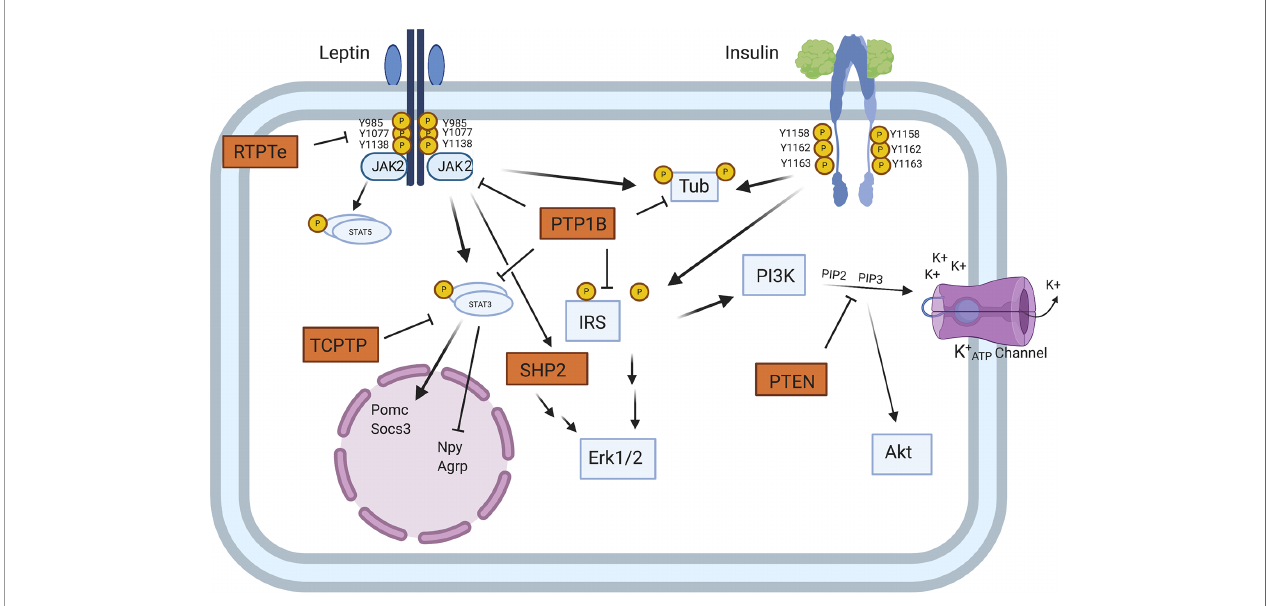
FIGURE 1 | Model of PTP regulation of central leptin and insulin signaling. When circulating leptin binds to its receptor LepRb, the associated tyrosine kinase JAK2 autophosphorylates and phosphorylates speci fi c tyrosine residues along the intracellular tail of the LepRb. Phosphorylation of Y985 allows for recruitment of the PTP SHP2 which mediates downstream ERK1/2 signaling, while phosphorylation of Y1138 allows for activation of STAT3 which regulates transcription of key neuropeptides involved in energy homeostasis. Unlike leptin signaling, insulin binding to its receptor results in receptor autophosphorylation at tyrosine residues 1158, 1162, and 1163. This allows for recruitment of the effector IRS, which upon phosphorylation can recruit adaptor molecules and mediate downstream PI3K and ERK1/2 signaling. In contrast to SHP2 which positively regulates leptin signaling, several PTPs can negatively regulate central leptin and insulin signaling. PTP1B inhibits leptin and insulin signaling by dephosphorylating JAK2 and the IR, respectively. Additionally, PTP1B has been implicated in dephosphorylating the downstream leptin/insulin signaling protein Tub. Like PTP1B, RPTPe has been shown to inhibit leptin signaling at the level of JAK2, while TCPTP negatively regulates leptin signaling via dephosphorylation of STAT3. PTEN antagonizes neuronal insulin-induced PI3K signaling via dephosphorylation of the phospholipid PIP3 into PIP2, resulting in decreased K+ ATP channel conductance [from Tsou and Bence (42)]. Figure created with